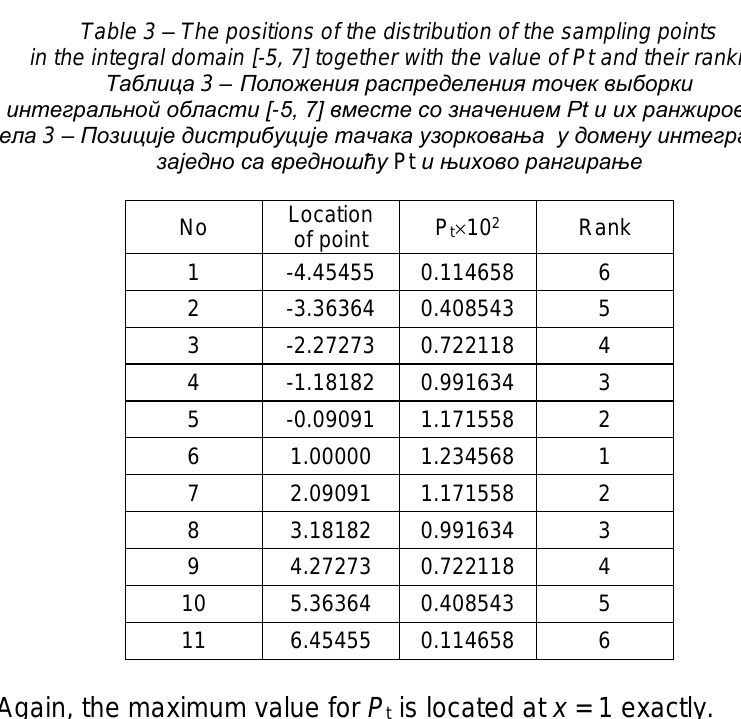
Table 3 – The positions of the distribution of the sampling